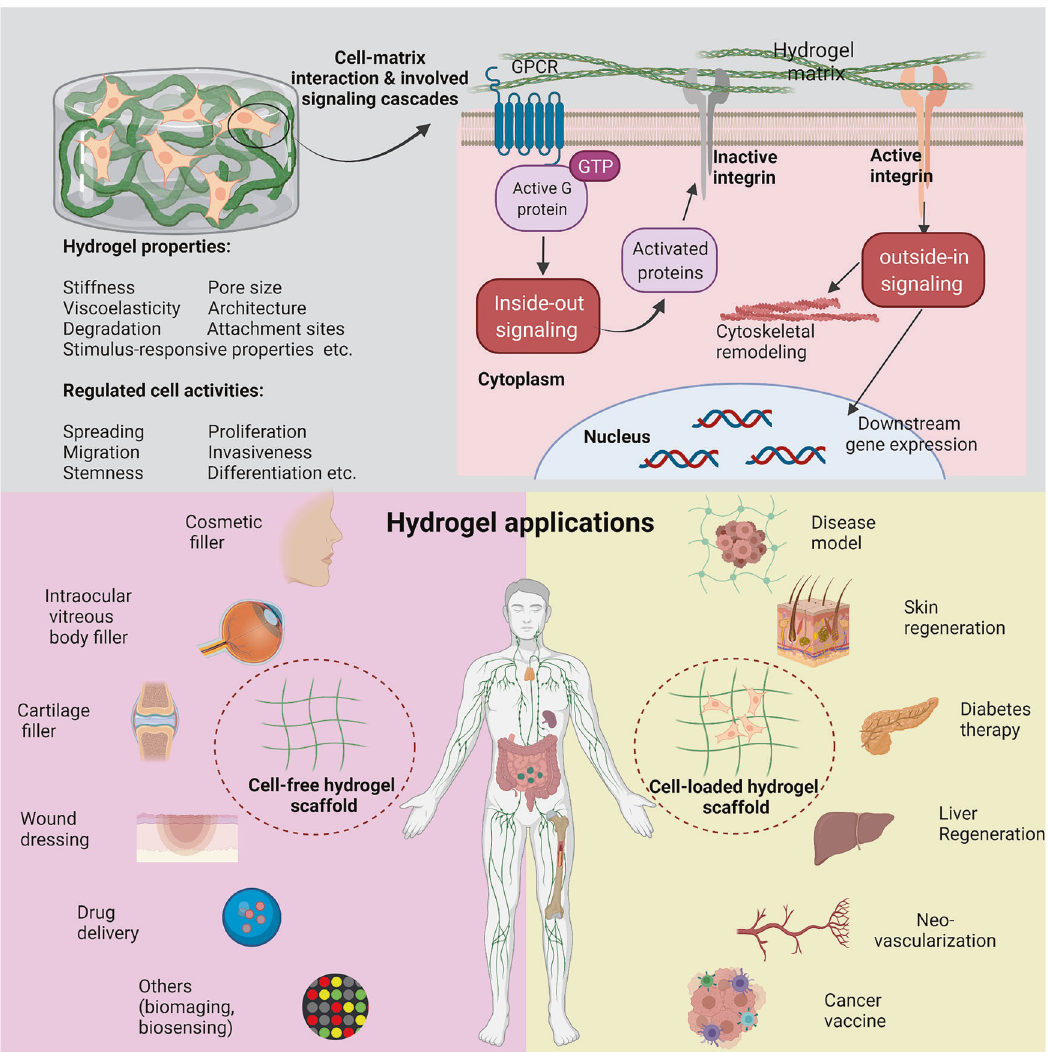
Fig. 1 Schematic images for indicating the interactions between cell and hydrogel matrix, uncovering the in fl uences of hydrogel physicochemical properties on cell biology via correspondingly triggering signaling cascades (e.g., inside-out and outside-in signaling), and illustrating various hydrogel biomedical applications of cell-free and cell-loaded